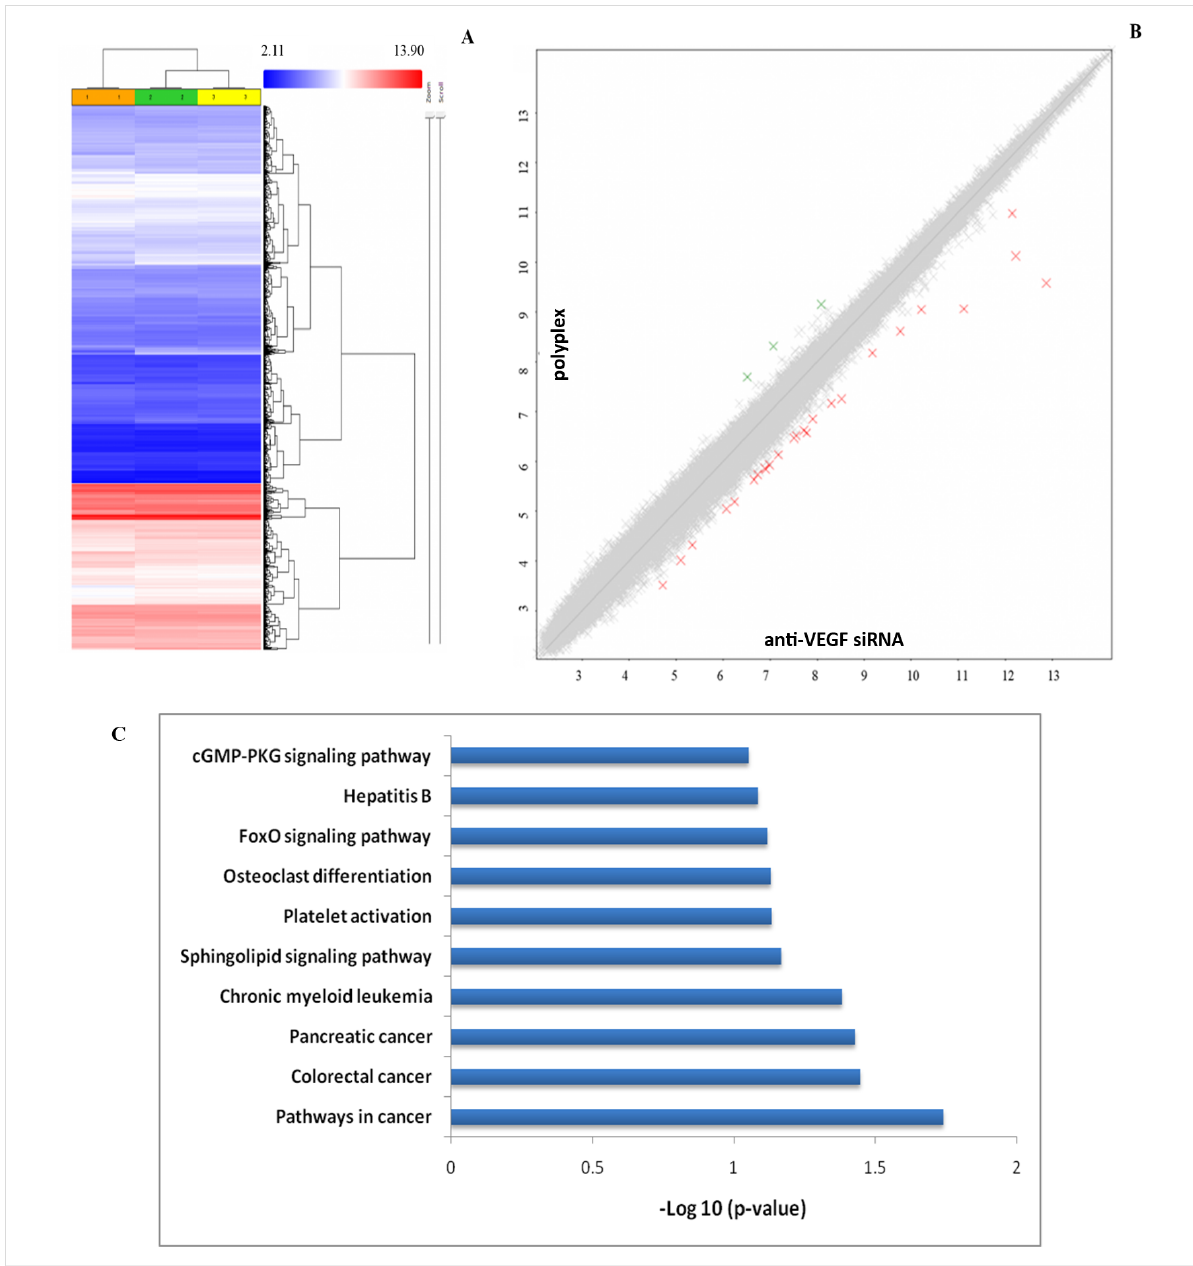
Figure 14: (A): Hierarchical clustering obtained from the microarray analysis (49,372 genes). Each row represents various genes and each column represents different samples. Column 1: (orange): control; column 2 (green): free siRNA, and column 3 (yellow): polyplex-treated cells. All experi- ments were carried out in replicates. (B) Scatter plot representing the gene expression profile of the polyplex as a function of that of anti-VEGF si-RNA (2) obtained from the microarray analysis. Total number of genes expressed: 49,372; green crosses: up-regulated genes; red crosses: down- regulated genes; grey crosses: genes with unchanged expression levels. (C) The KEGG pathway indicating the number of genes modulated by the polyplex treatment in A549 cells when compared with to the treatment with free siRNA.